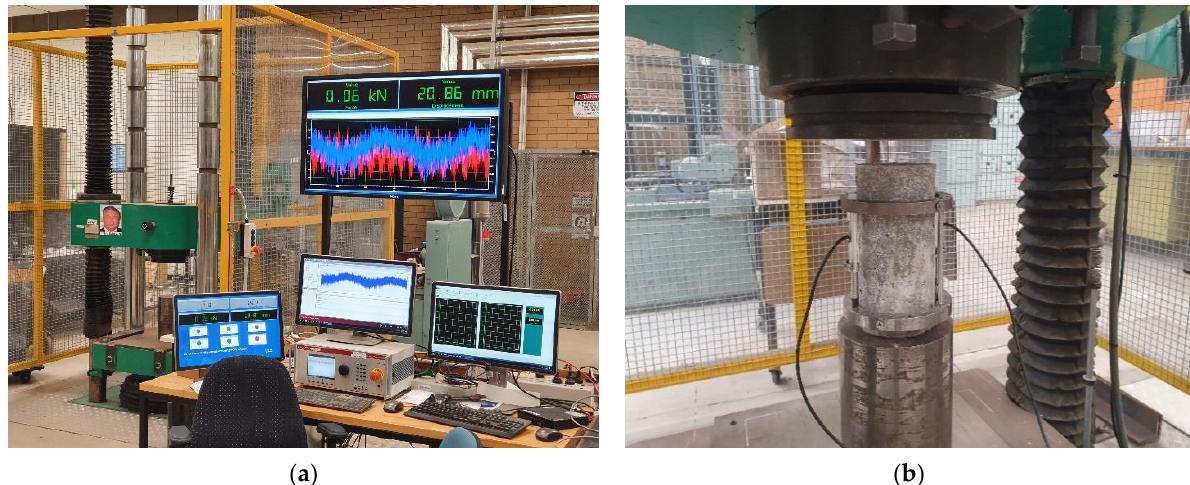
Figure 3. ( a ) Baldwin compression machine; ( b ) Stress-strain curve testing